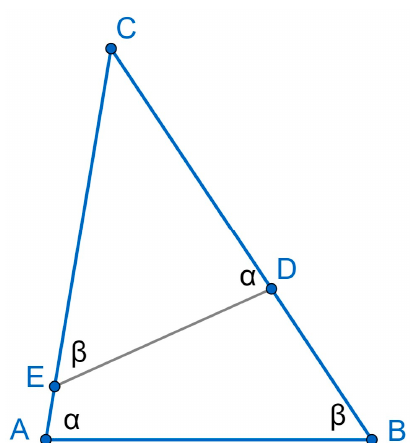
Figure 3. The “Subcontrary” Section” of a Triangle. Triangle DEC is subcontrary to ABC